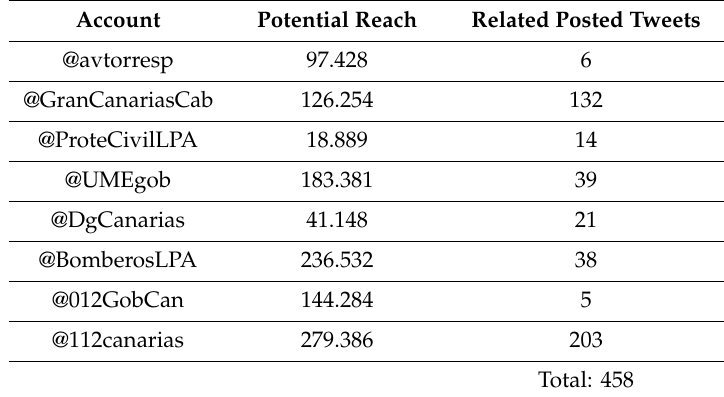
Table 3. Potential reach of Twitter accounts. Source: Union Metrics. Own